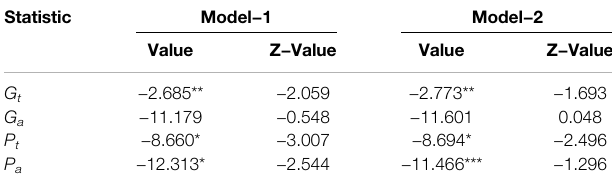
TABLE 5 | Westerlund cointegration test